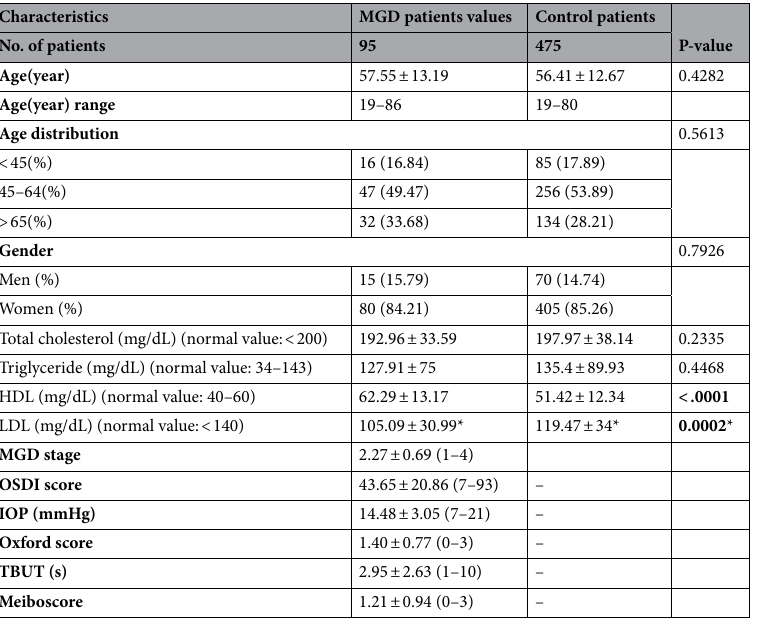
Table 1. Clinical characteristics of patients who applied propensity score methods (1:5). Values are presented as mean ± Standard deviation (range) or number (%). HDL high-density lipoprotein, LDL Low-density lipoprotein, OSDI Ocular surface disease index, IOP intraocular pressure, TUBT tear film break-up time. *Since KNHAES did not conduct an LDL survey in 2012, we calculated the LDL concentration using the Friedewald equation for both group of MGD and